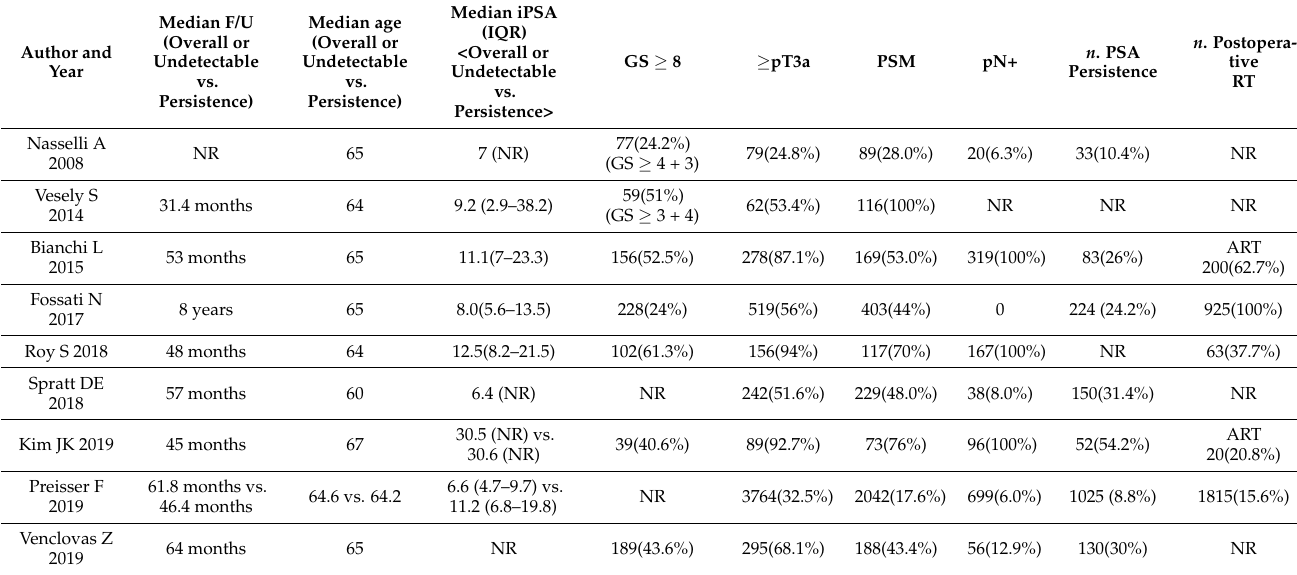
Table 2. Patient characteristics of nine studies included in this systematic